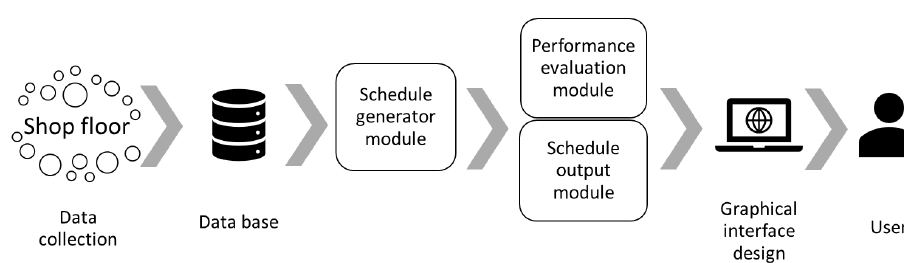
Figure 1. A scheduling system (figure modified from [1]).